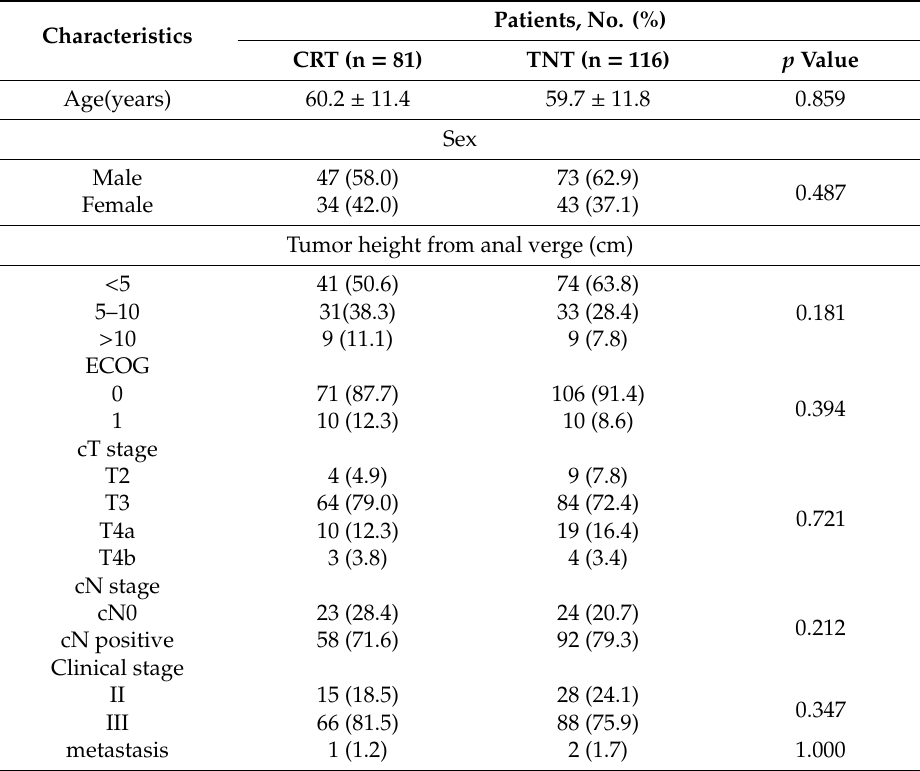
Table 1. Patients’